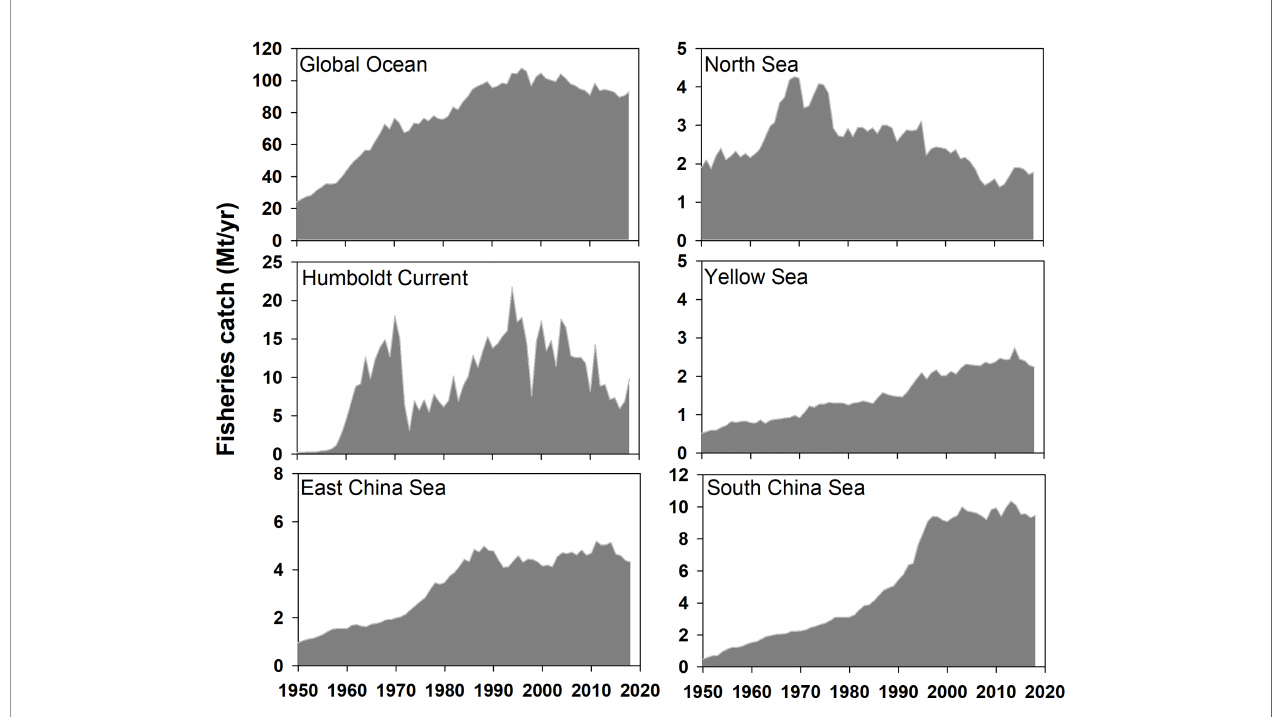
FIGURE 3 | Fisheries catch (Mt/yr) in the global ocean and fi ve LMEs from 1950 to 2018.